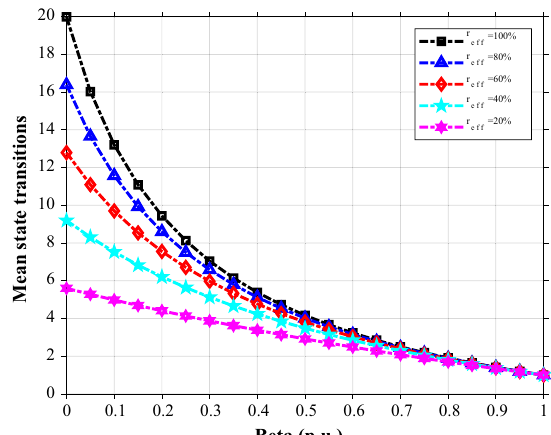
Fig. 13 Mean system state transitions with imperfect repairs – 90% diagnostic coverage